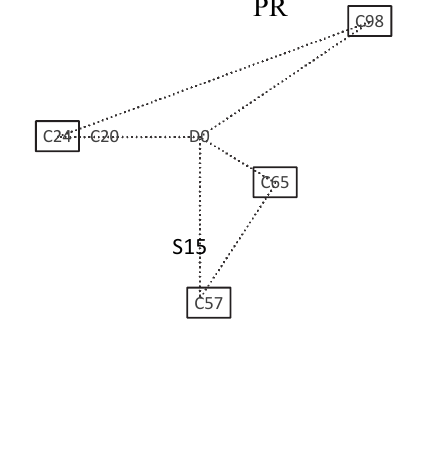
Fig. 1. Routes of instance c103-5 Results for the MDEVLRPTW-BS, MDEVLRPTW-BSPR, and the MDEVLRPTW-PR, minimizing the overall distance traveled MDEVLRPTW-BS MDEVLRPTW-BSPR MDEVLRPTW-PR